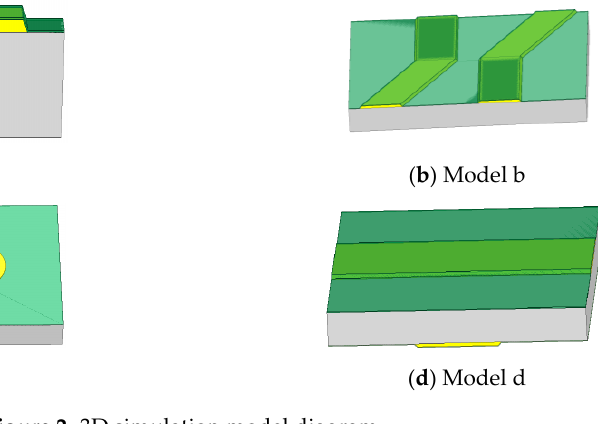
Figure 2. 3D simulation model diagram.